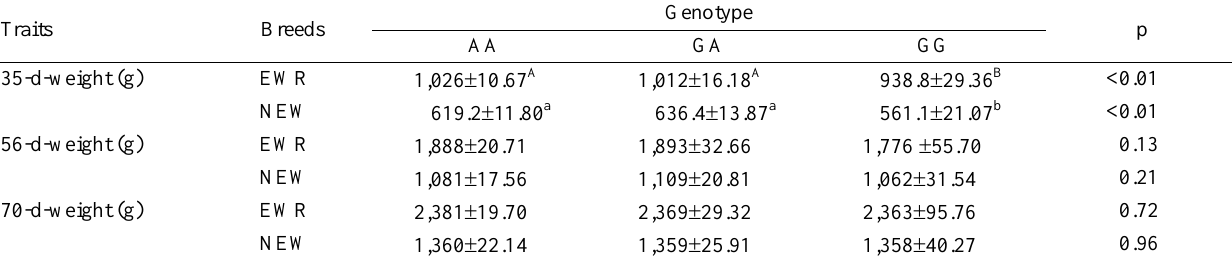
Different lowercase letters and capital letters mean significant difference at 0.05 and 0.01 levels, respectively. NEW = New Zealand white rabbit; EWR = European white rabbit.